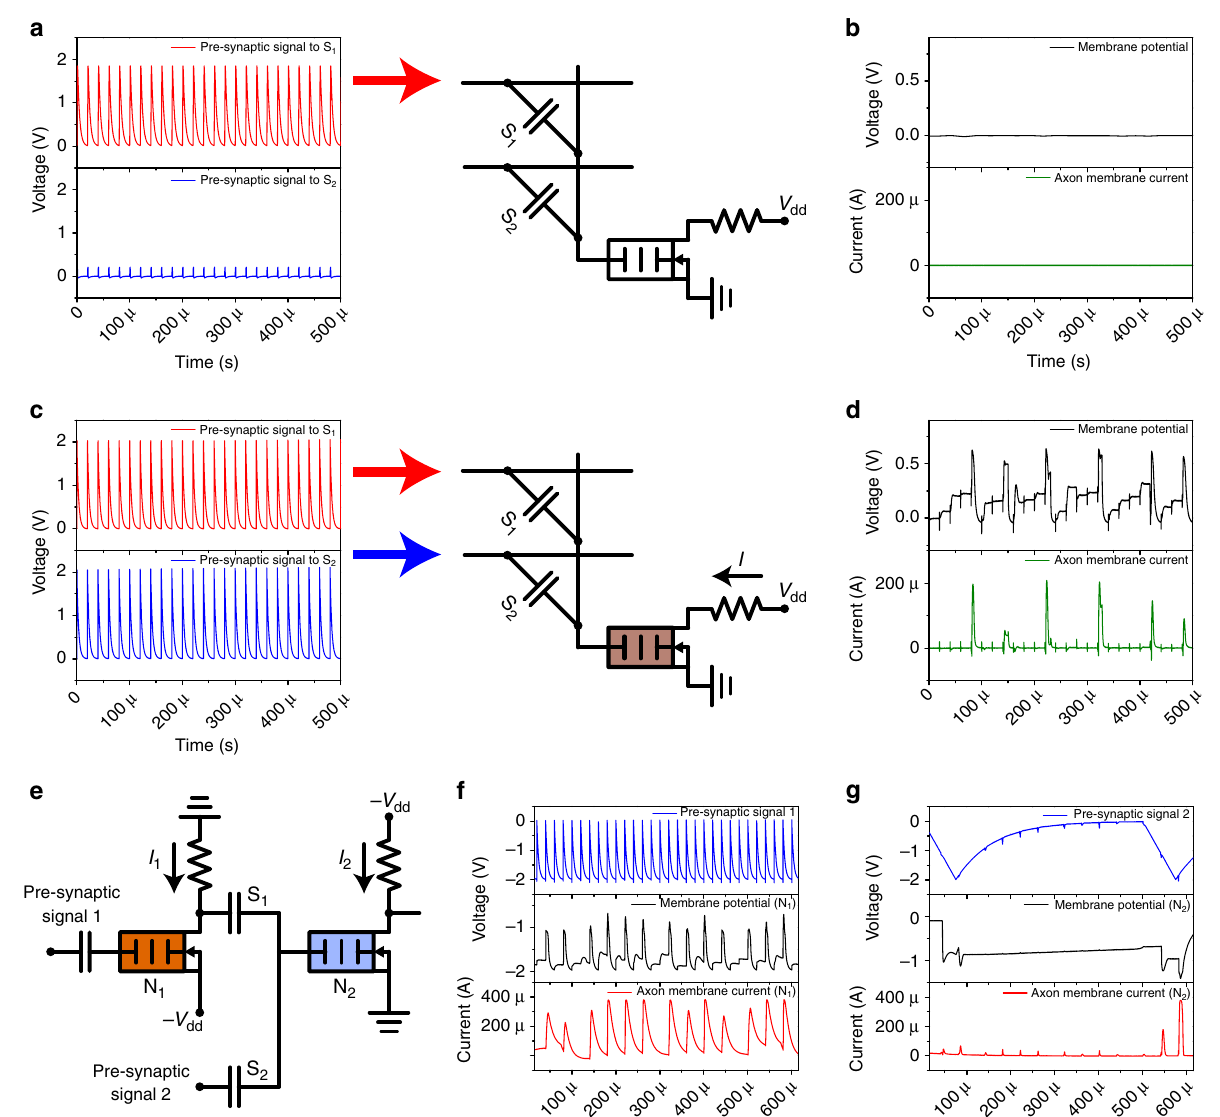
Fig. 2 Dendritic spatial summation and signal propagation of neuro-transistors. a , c Input signals and circuit diagrams. The red and blue curves represent the “ pre-synaptic ” voltage spikes to two capacitive synapses. The DPM serves as the gate of the neuro-transistor with two capacitively-coupled fi xed- weight synapses S 1 and S 2 . b , d The triggered gate potential, representing the membrane potential of a biological neuron, and the drain current, corresponding to the axon current of the neuro-transistor, depicted by the black and green curves, respectively. In the case that a single synapse was excited, the resultant stimulation could not trigger output pulses. However, concurrent stimulation of both synapses produced clear temporal integration on the neuro-transistor gate and the associated spikes in the output current. e Circuit diagram of cascaded neuro-transistors N 1 (n-MOSFET) and N 2 (p-MOSFET). Fixed capacitance synapses were used with equal weights (680 pF). f The fi rst stage N 1 integrated the fi xed-frequency input signal 1 (blue line) and fi red periodically (black and red lines), with some variation in the integration time. g The voltage to the second stage N 2 was the weighted sum of the voltage on S 1 resulting from the output of N 1 and the input signal 2 (blue line), with the resulting N 2 gate potential (black line) and the second stage output current (red line) shown. The fi ring of the second stage neuro-transistor N 2 illustrates both spatial summation and sustainable signal